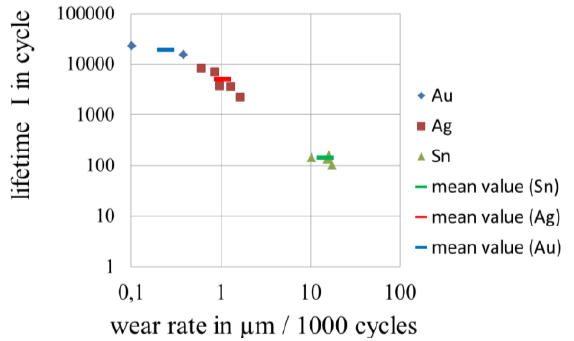
Figure 31. Correlation between the rate of wear and lifetime I of electrical contacts with different coating materials.